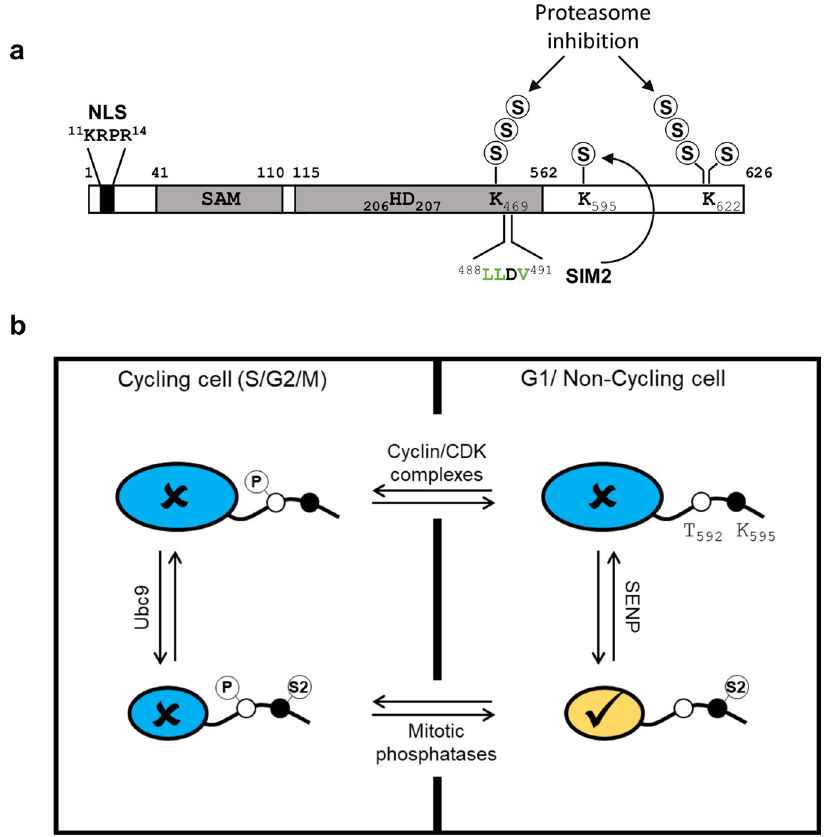
Fig. 7 Model for the regulation of SAMHD1 antiviral activity by SUMOylation in non-dividing cells. a Human SAMHD1 harbors three major SUMO- attachment sites: K595 and K622 undergo mono-SUMOylation, while K469 and K622 are targeted by SUMO chains, which accumulate upon inhibition of the proteasome. Human SAMHD1 also harbors the surface-exposed SIM2 sequence, which drives the modi fi cation of K595 by SUMO, likely with a preference for the SUMO2 isoform (S2). b In actively dividing cells, SAMHD1 is targeted by CDK/cyclin-mediated phosphorylation on T592 during the G1/ S transition thereby losing its antiviral activity ( ✗ , colored in blue). A fraction of SAMHD1 (smaller circle) is SUMOylated on K595 by the action of Ubc9. However, this modi fi cation appears insuf fi cient to fully neutralize the effects of phosphorylation and rescue restriction. Upon mitotic exit, phosphorylation is reversed by host PPP family phosphatases. Our results show that SAMHD1 harboring dephosphorylated T592 is antivirally inactive if SUMO-conjugation to K595 is prevented. They also indicate that only the fraction of SAMHD1 that harbors SUMOylated K595 and dephosphorylated T592 ( ✓ , colored in yellow) ef fi ciently inhibits viral infection through a dNTPase-independent